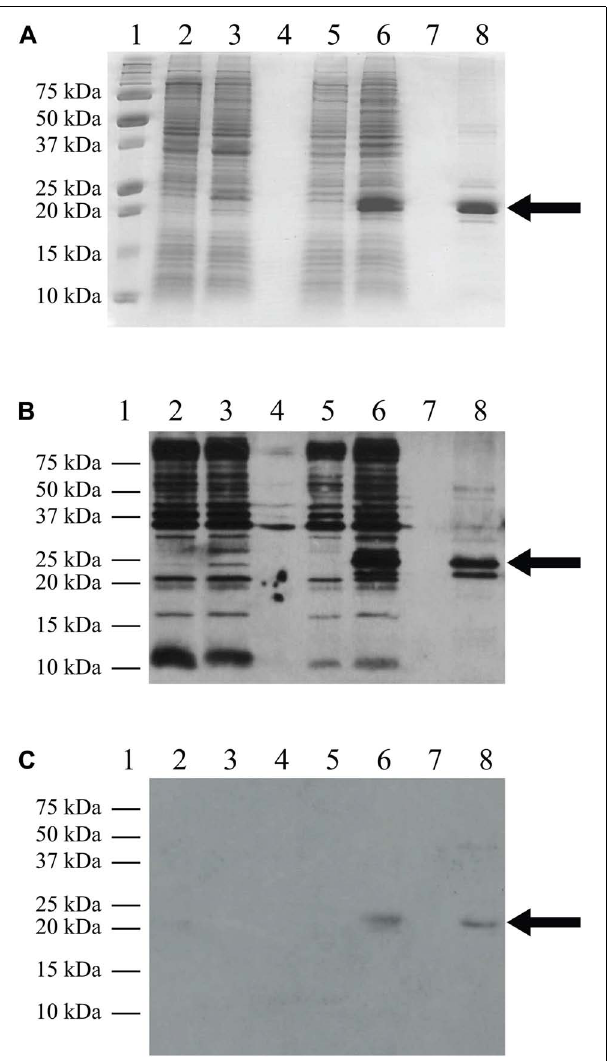
FIGURE 3 |Western blot analysis. C41(DE3)pLysS transformed with the empty pET-14b vector (lanes 2 and 3) or theTM4-Cx45CT plasmid (lanes 5 and 6). Lane 8 contains theTM4-Cx45CT after purification. Lane 1 contains the Precision Plus Protein All Blue Standards molecular mass marker (Bio-Rad) and lanes 4 and 7 are blank. Samples were collected just prior to (lanes 2 and 5) and 4 h afterIPTG induction (lanes 3 and 6). A total of 500 μ L samples with an Abs 600 nm at 0.5 were pelleted and resuspended in 30 μ L of 6 × SDS loading buffer. Equal amounts of total protein (7 μ L) were ran on a 15% SDS-PAGE gel. (A) Coomassie Blue stained gel is shown as a reference.Western blot analyses were performed using either (B) anti-His6, or (C) anti-Cx45 primary antibodies.The expected molecular mass of theTM4-Cx45CT is ∼ 22 kDa, which is indicated by the arrow. Of note, in (B) lane 8, the anti-His6 primary antibody also reacted with a ∼ 20 Da protein. Although not present in the (A) 15% SDS-PAGE gel or reactive with the (C) anti-Cx45 primary antibody, we speculate the doublet is caused by proteolysis of theTM4-Cx45CT.